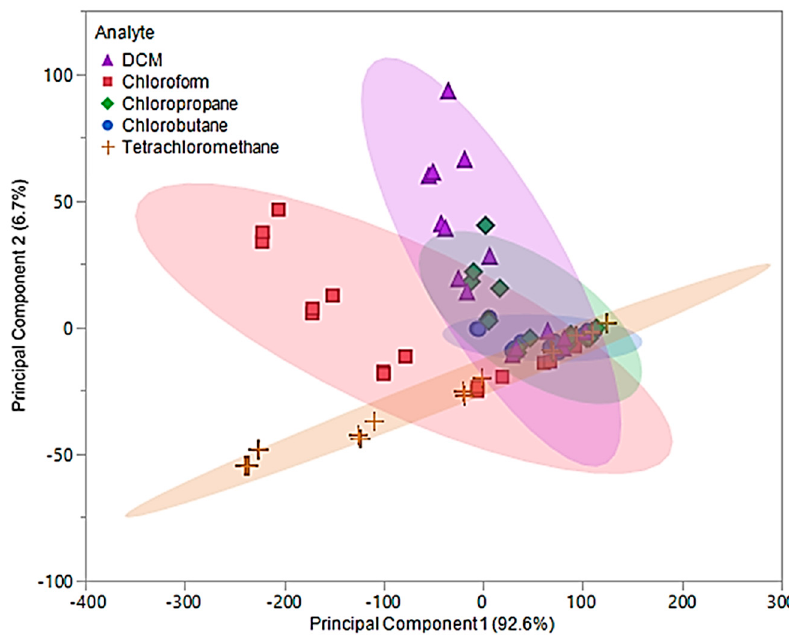
Figure 6. Principal component plot for discrimination of five chlorinated VOCs with respect to a three sensor MSA. The plot considers 75 total measurements consisting of three replicate measurements at five different flow ratios for each VOC (15 measurements per sample) using pure IL sensors.